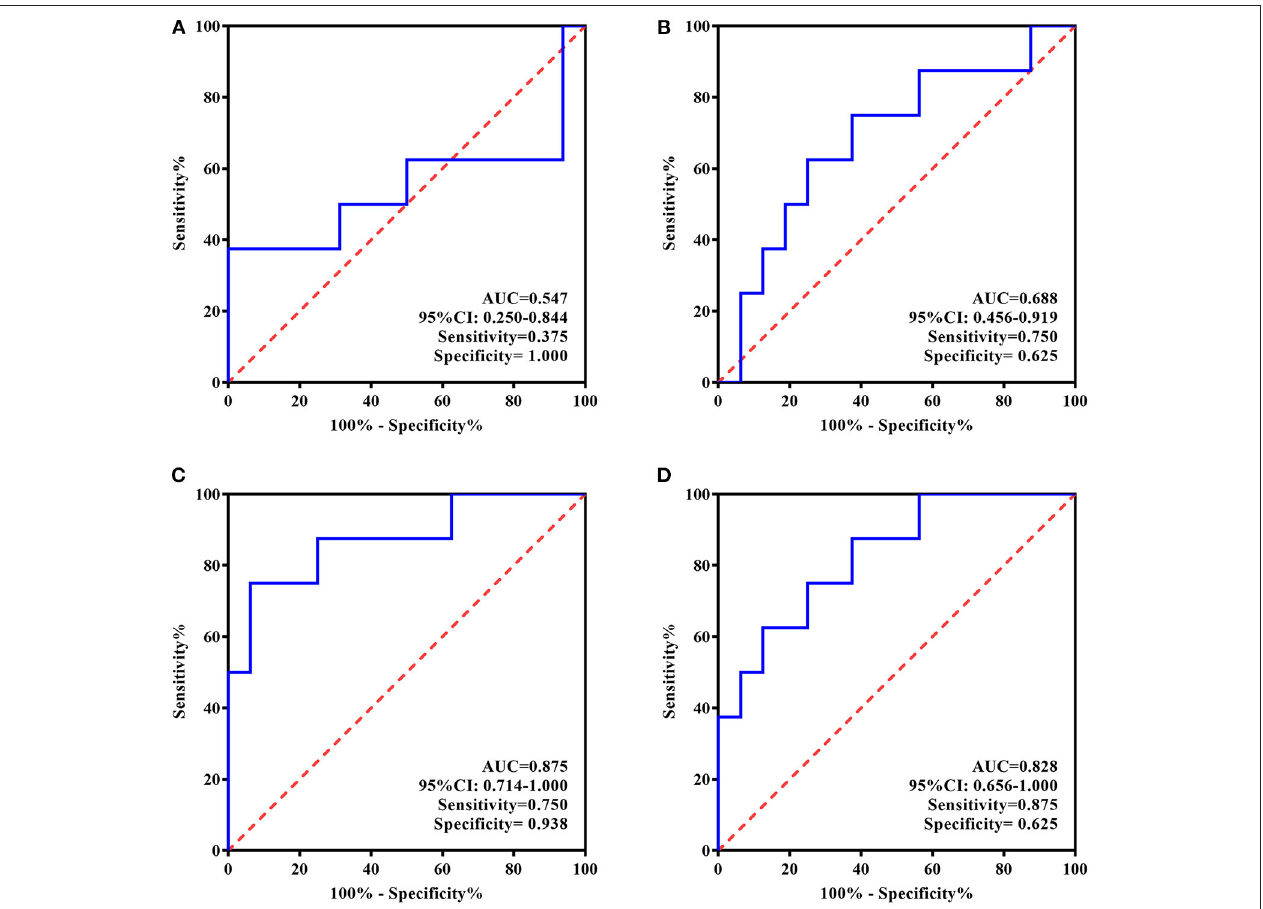
FIGURE 4 | ROC Curve for the evaluating and predicting performance of ATIII in the individualized group. (A) ROC curve of ATIII at baseline for predicting the response to 5-day treatment; (B) ROC curve of ATIII at baseline for predicting the remission in 4 weeks following the treatment termination; (C) ROC curve of ATIII at day 5 for estimating the response to 5-day treatment; (D) ROC curve of ATIII at day 5 for predicting the remission in 4 weeks following the treatment termination. ROC curve, receiver operating characteristic curve; AUC, area under the curve; CI, confidence interval.